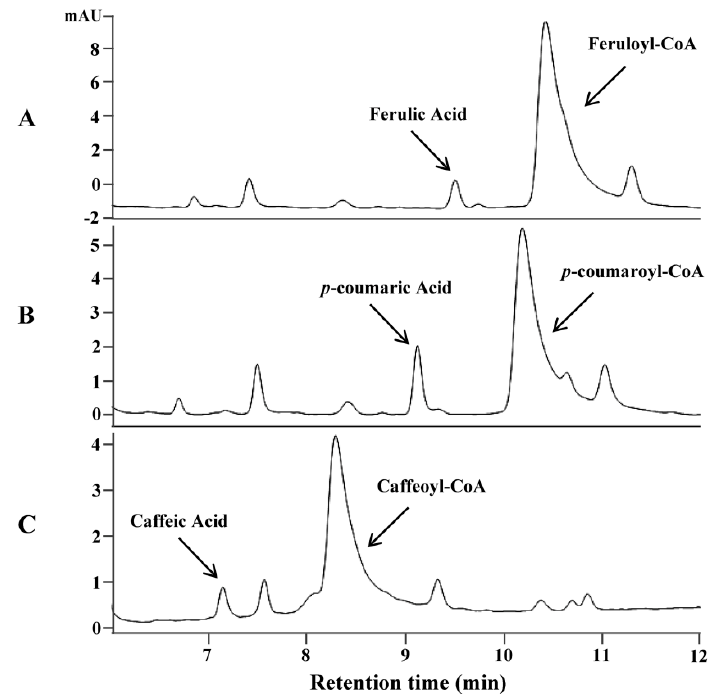
Figure 1. In vitro assays of oat 4CL gene (As4CL1) using the protein expressed in E. coli on three substrates. HPLC analysis of the products on substrate ferulic acid ( A ), p -coumaric acid ( B ), and caffeic acid ( C ).